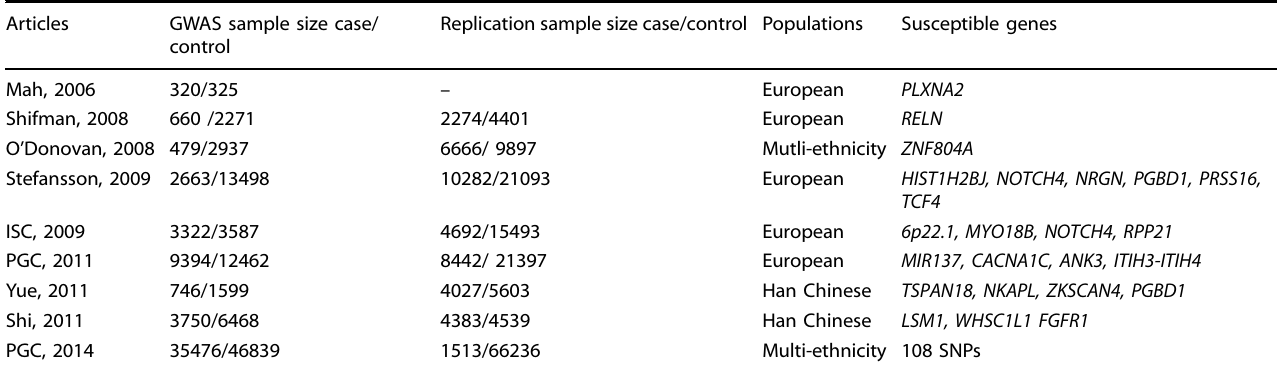
Table 1. Summary of progress in GWASs of schizophrenia mainly in European populations and two studies in Chinese Han population